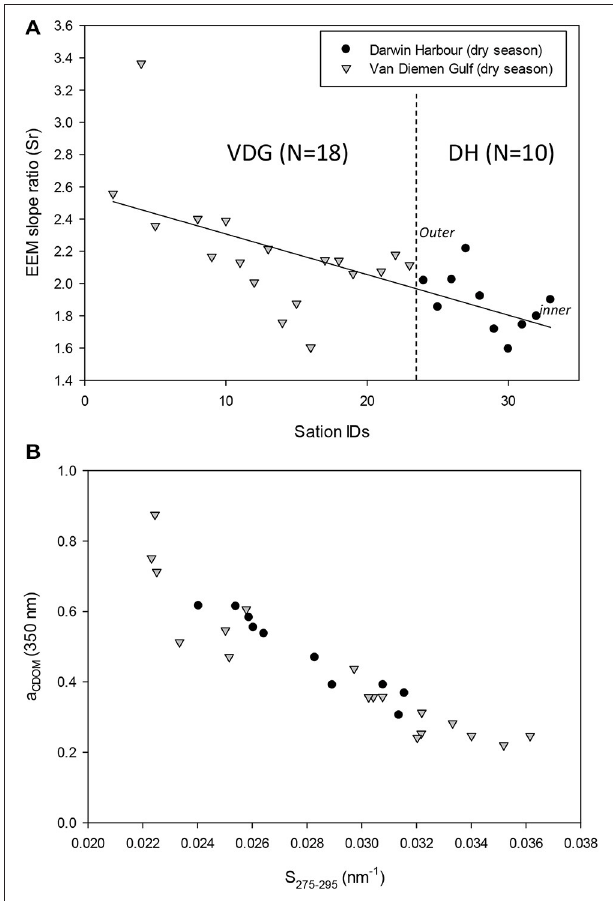
FIGURE 13 | (A) EEM spectral slope ratios (Sr) showing a decline through the course of the 2013 dry season field campaign from the VDG to DH and (B) relationship between aCDOM and the EEM spectral slope in the